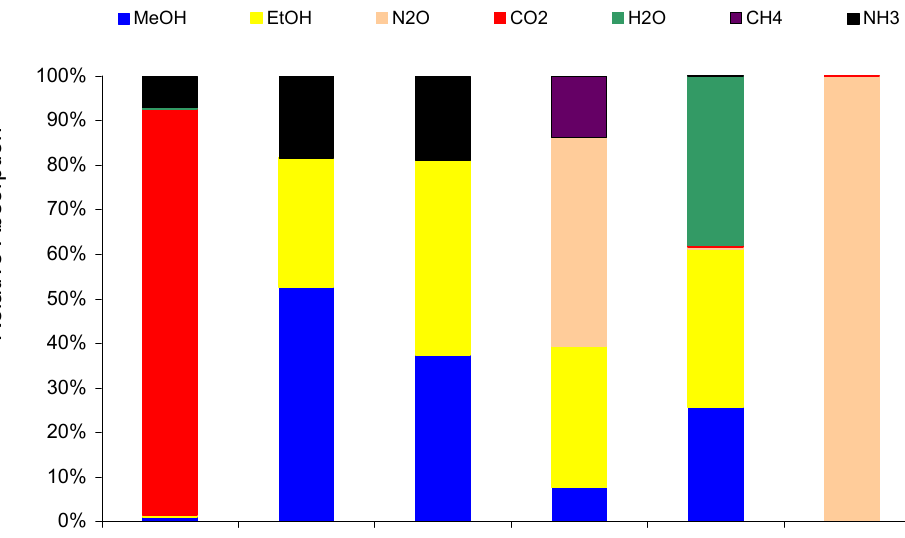
Figure 4. Relative absorption of 1 ppm non-target NH filter in Example